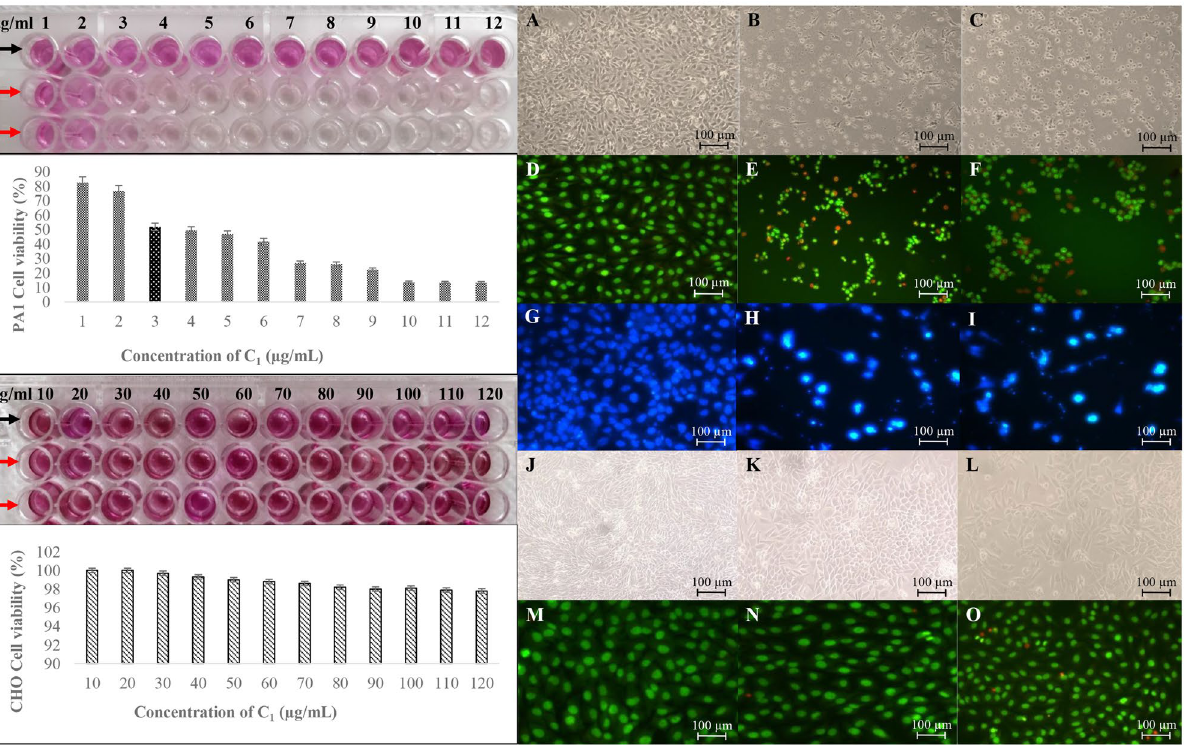
Figure 2. Cell viability assayed by formation of formazan crystals for the ovarian cancer (PA1) and normal Chinese Hamster Ovary (CHO) cell lines treated with C 1 (red arrowheads and control indicated with black arrowheads) [left panel up and down respectively] with their IC 50 values graphed right below. The compound C 1 does not inhibit CHO cell lines even at 40 folds the IC 50 concentration of PA1 cells (3 µg/mL [5.8 µM]). The right panel has micrographs of PA1 untreated cells [phase contrast ( A ), Acridine Orange/Propidium Iodide (AO/PI) double-stained ( D ) and 4 ′ ,6-diamidino-2-phenylindole (DAPI) stained ( G )]. ( B , E , H) are respectively for C 1 treated cells, whilst ( C , F , I ) are Doxorubicin (IC 50 5 µg/mL [8.6 µM]) treated cells in the same sequence. ( J ) (Phase contrast) and ( M ) (AO/PI double-stained) represent CHO untreated cells, ( K ) and ( N ) are C 1 treated while ( L ) and ( O ) are the Doxorubicin treated ones in the same